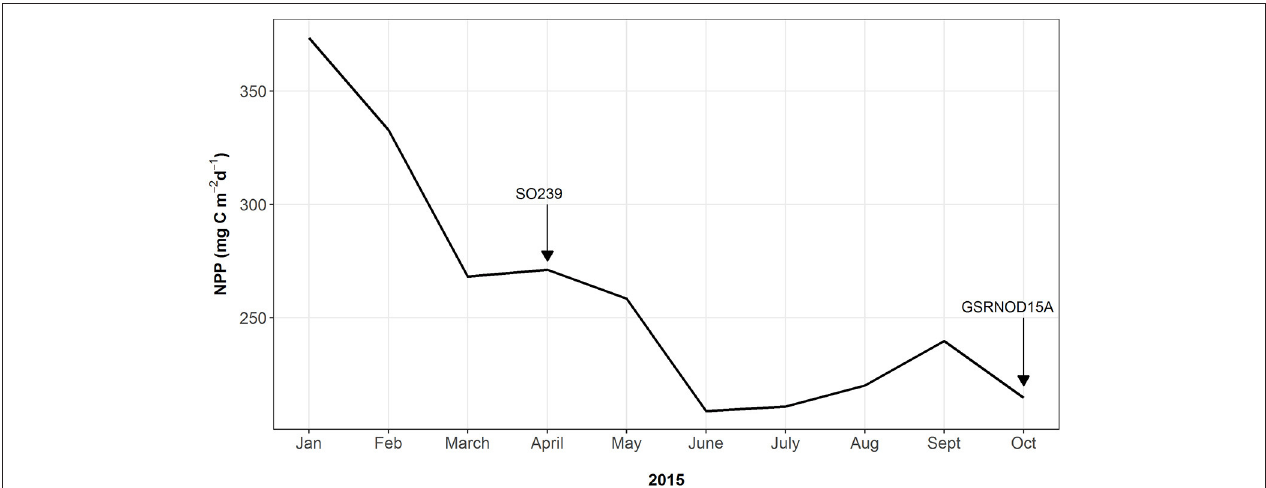
FIGURE 3 | Monthly-averaged daily net primary productivity (NPP) for the surface water at site B6S02 for January–October 2015. Arrows indicate the timing of the SO239 cruise (April 2015) and that of the GSRNOD15A cruise (October